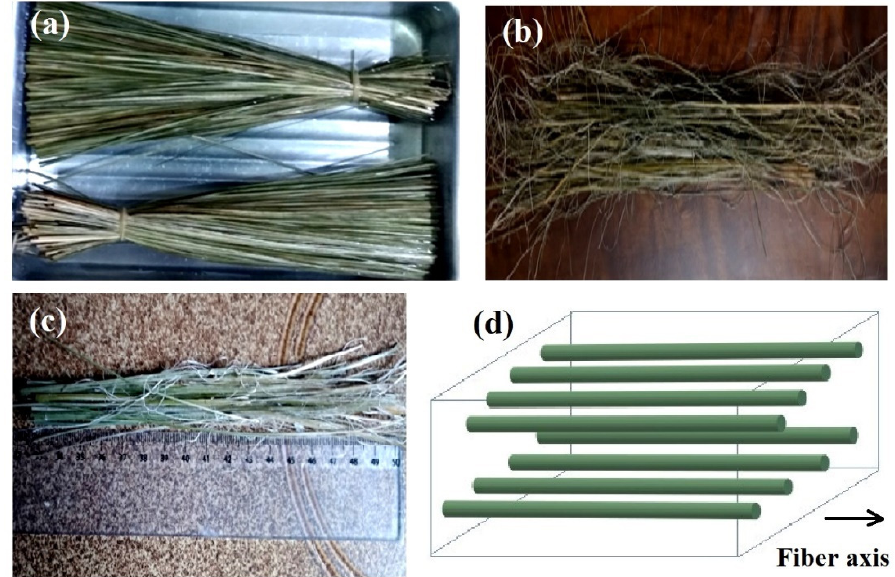
Figure 1. The extraction process of the fibers: ( a ) Cyperus malaccensis (CM) sedge immersed in water for a period of 24 h; ( b ) shredded fibers; ( c ) fibers already cut 150 mm in length; ( d ) schematic diagram of the aligned arrangement of the fibers in the composite.